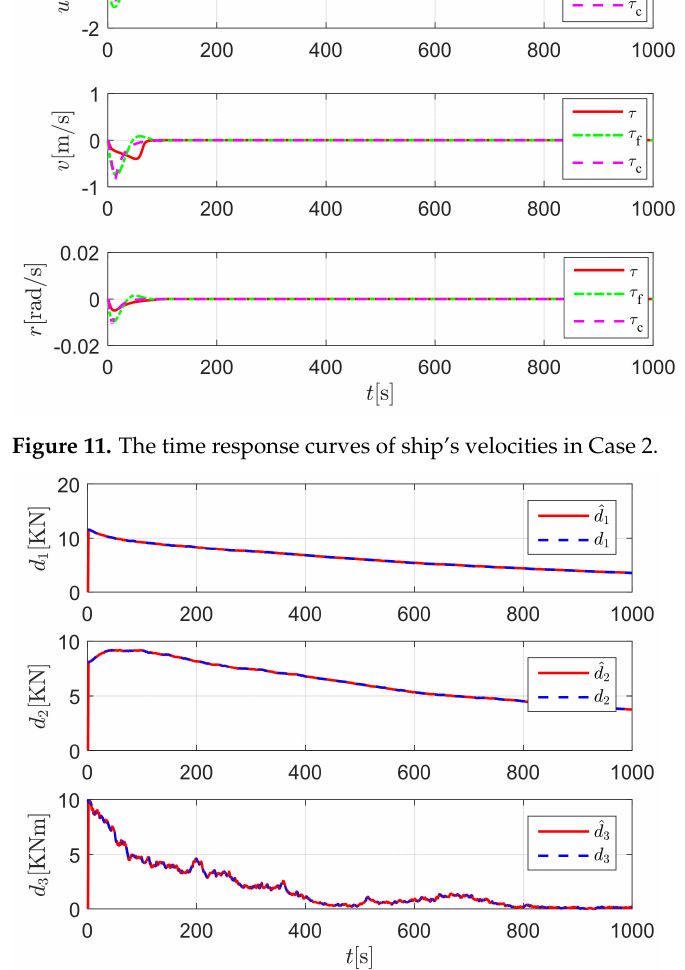
Figure 12. The estimation curves of τ and τ c for external disturbances.